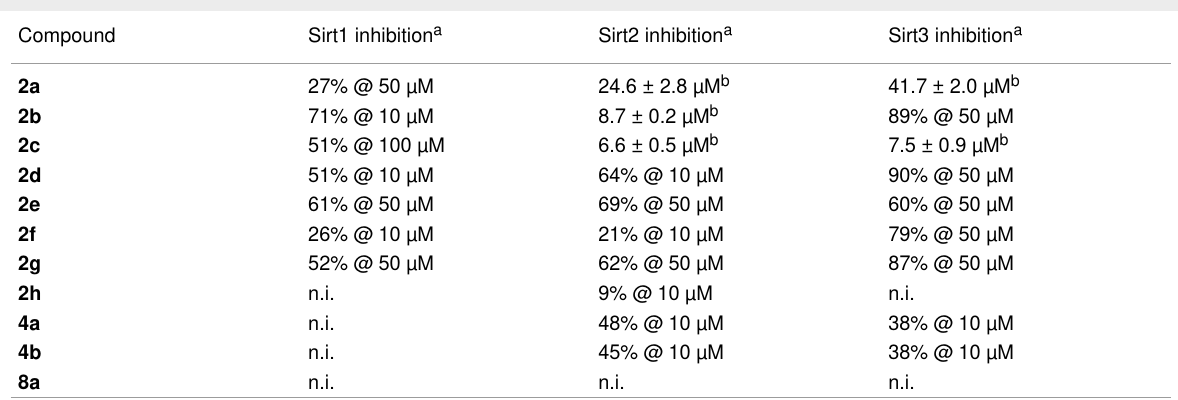
Table 1: Sirt1–3 inhibition for compounds 2a–h , 4a / 4b and 8a